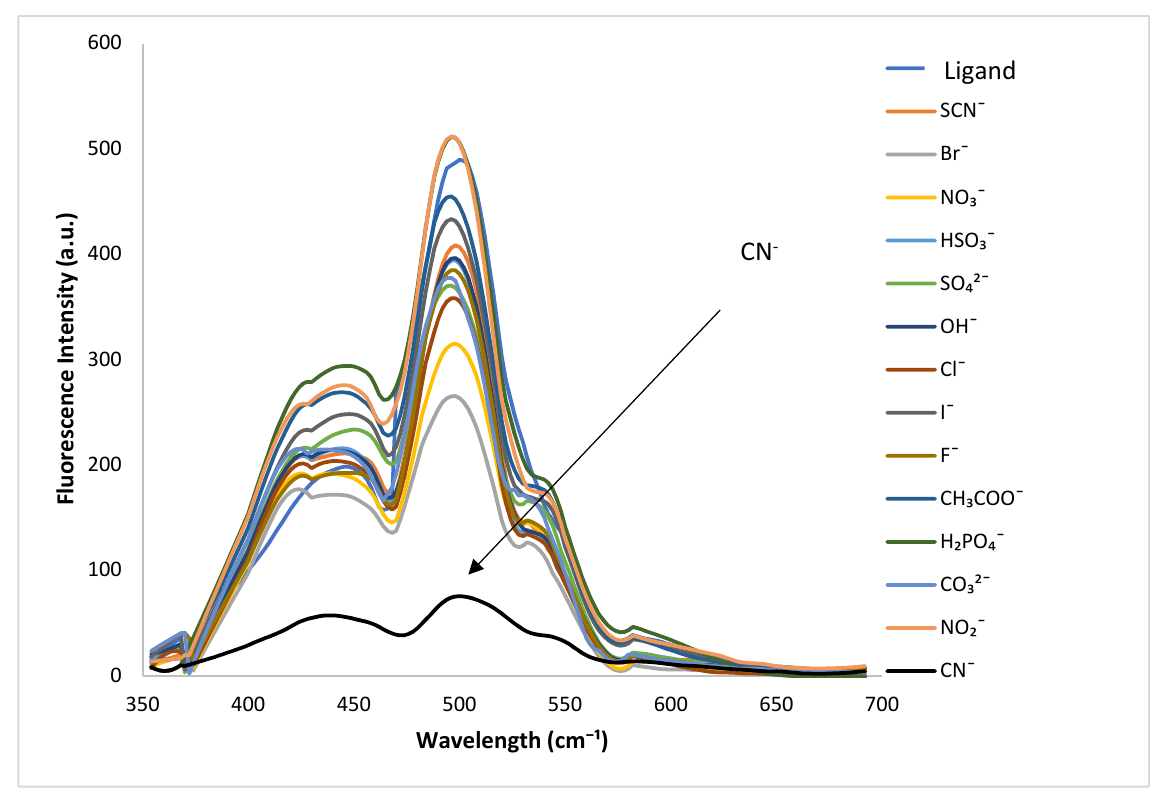
Figure 4. Fluorescence spectra of the aqueous suspended fumed-Pr–Pi-TCT (3 mL H ₂ O suspension, 0.2 g L − 1 ) using different anions.